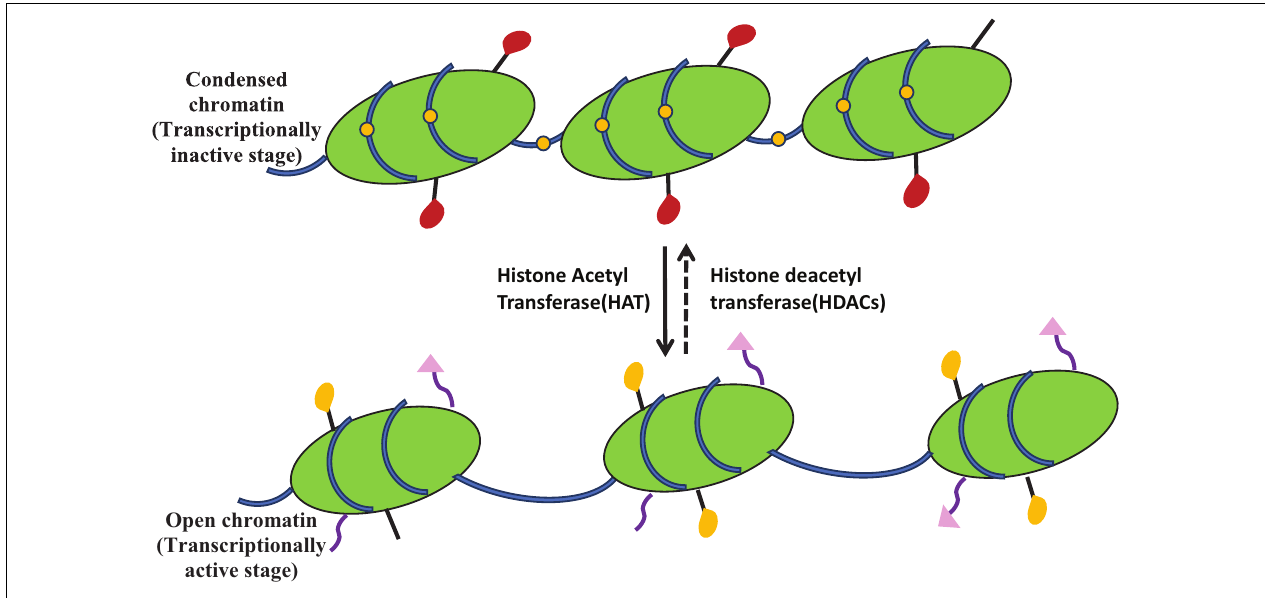
FIGURE 3 | Inhibition of DNA methyltransferase (DNMTs) by using DNMT inhibitors. Azacytidine used as a DNMT inhibitor are base analogs that prevent the transfer of the methyl group to cytosine by incorporating into nucleic acid. Inhibitors covalently attach to nucleic acid and lead to a hypomethylated state and activation of repressed